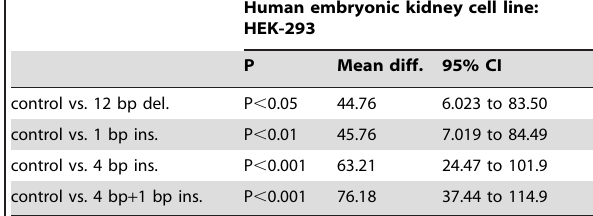
Table 7. Statistical significance of reduction of transcriptional efficiencies of indel polymorphic D Np63 promoters compared to normal controls.